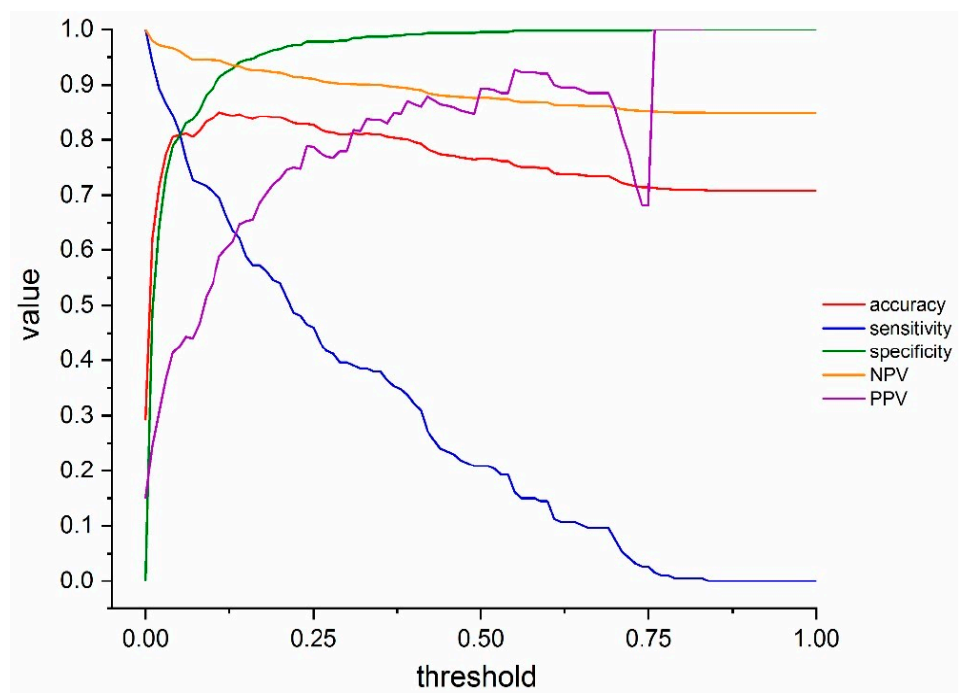
Figure 5. Classification performance plot. The classification performance in the test dataset, assuming a disease prevalence of 15%, in terms of accuracy (red line), sensitivity (blue line), specificity (green line), NPV (orange line) and PPV (purple line) for different decision thresholds.